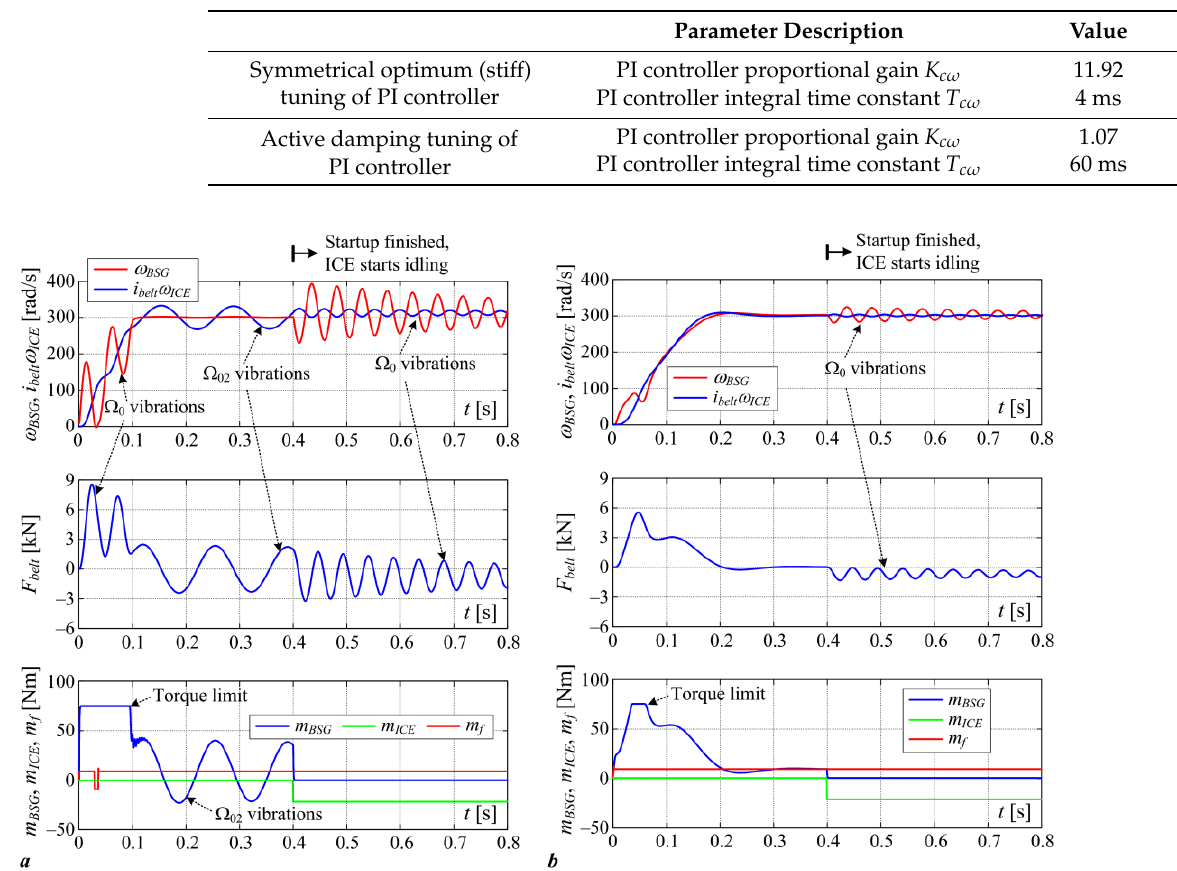
Figure 8. Comparative simulations’ results of ICE start-up via BSG drive followed by ICE idling: PI controller with “stiff” tuning ( a ) and active damping PI controller ( b ).